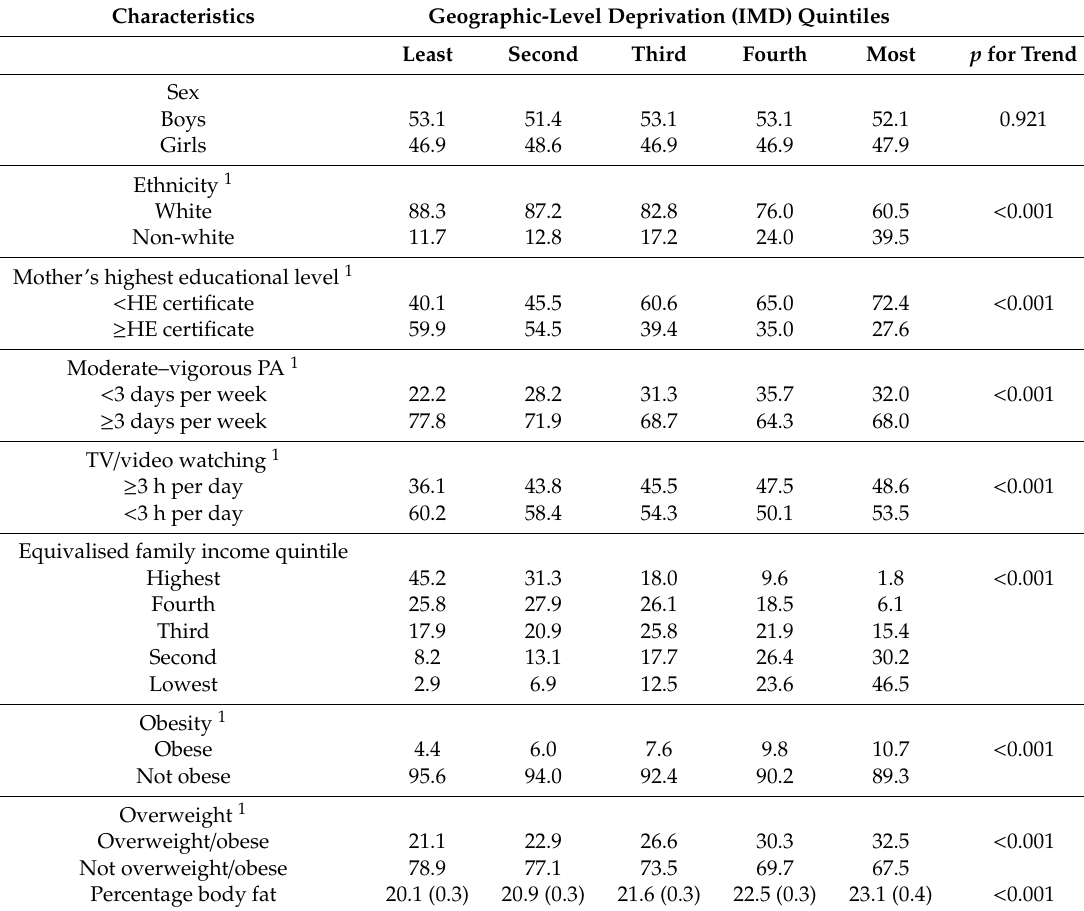
Table 2. Characteristics of sub-cohort in England by geographic-level deprivation quintiles ( N = 7716). Characteristics Geographic-Level Deprivation (IMD) Quintiles Least Second